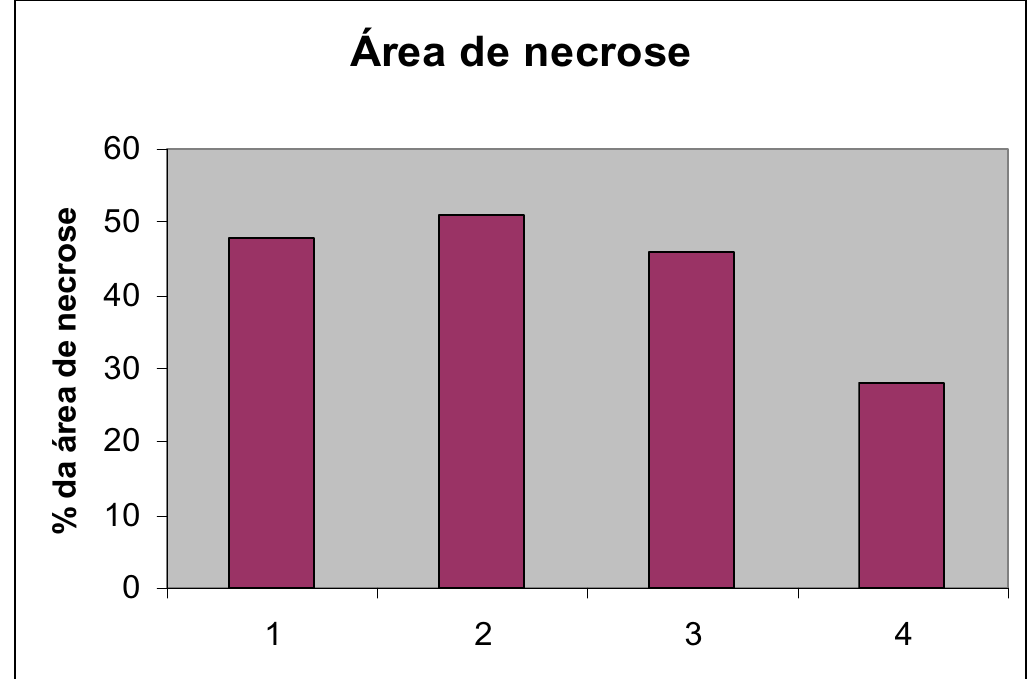
FIGURA 1 – Área de necrose do retalho cutâneo: grupo controle (1), grupo iontoforese placebo (2), grupo controle de absorção (3) e, grupo tratado (4), n=15 em cada grupo.